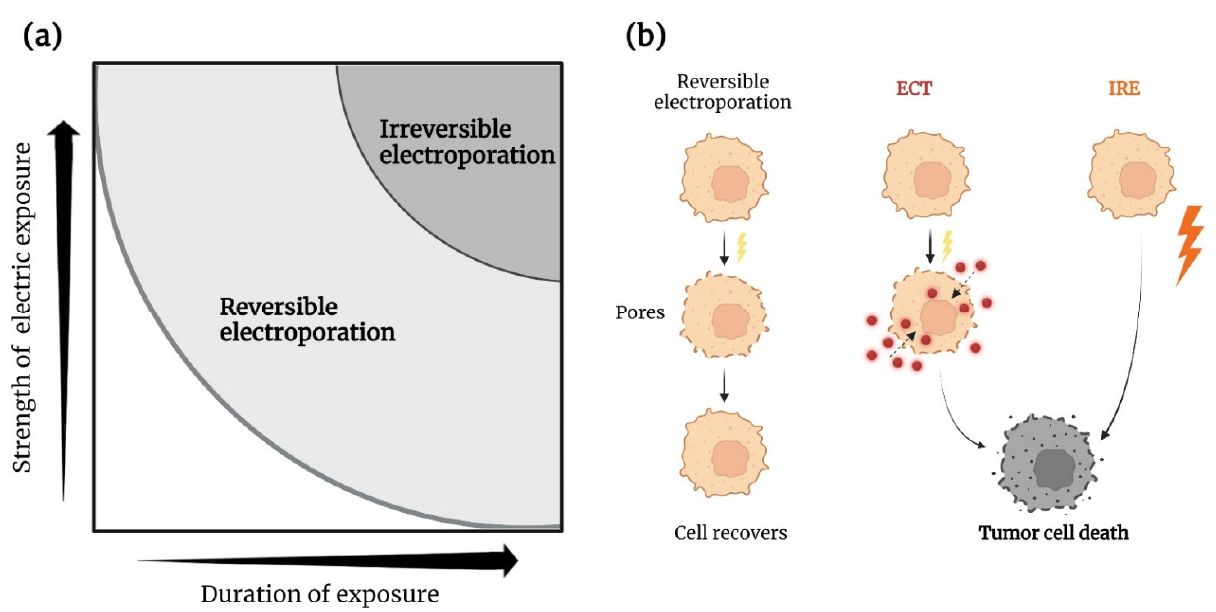
Figure 1. ( a ) The strength and duration of electrical stimulation determines the cellular outcome. ( b ) The addition of agents such as chemotherapy can prevent cancer cells from recovery and lead to cell death. ECT, electrochemotherapy; IRE, irreversible electroporation. Created with BioRender.com (accessed on 7 June 2022).